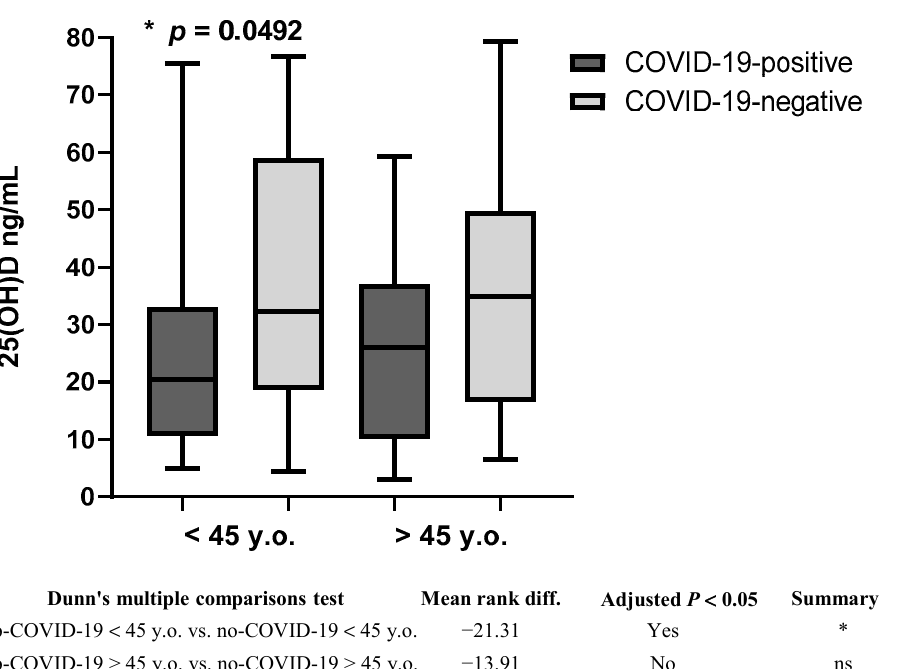
Figure 2. Plasma 25(OH)D levels among COVID-19 positive and COVID-19 negative participants in different age groups; * p = 0.0492, ns = not significant; y.o. = years old. The 25(OH)D levels in men and women were comparable in general (21.84 ± 33.72 ng/mL vs. 23.84 ± 32.01 ng/mL; p = 0.9989). This trend also persisted when comparing with groups ( p = 0.0636; Figure S2).